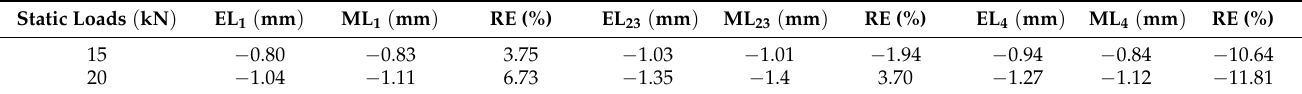
Table 6. Comparison of the deflections between experimental tests and numerical